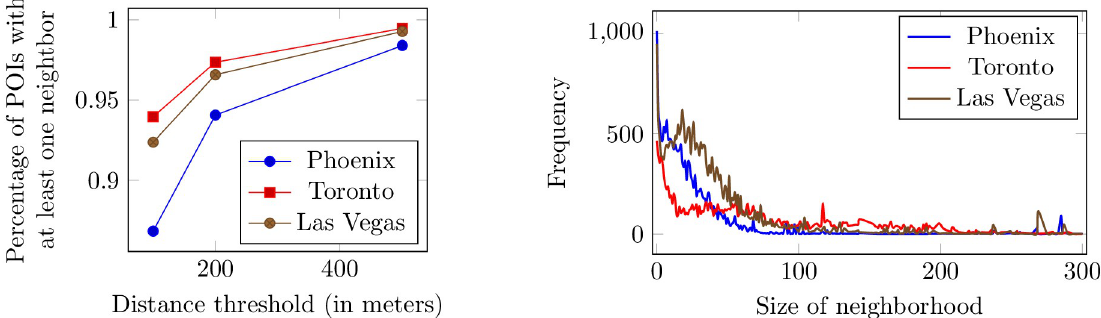
Fig 1. The percentage of POIs having at least one neighbor within a distance threshold of 100 m, 200 m, and 500 m (top). The frequency of different neighborhood sizes in each city, considering neighborhood size of 200 m (bottom).